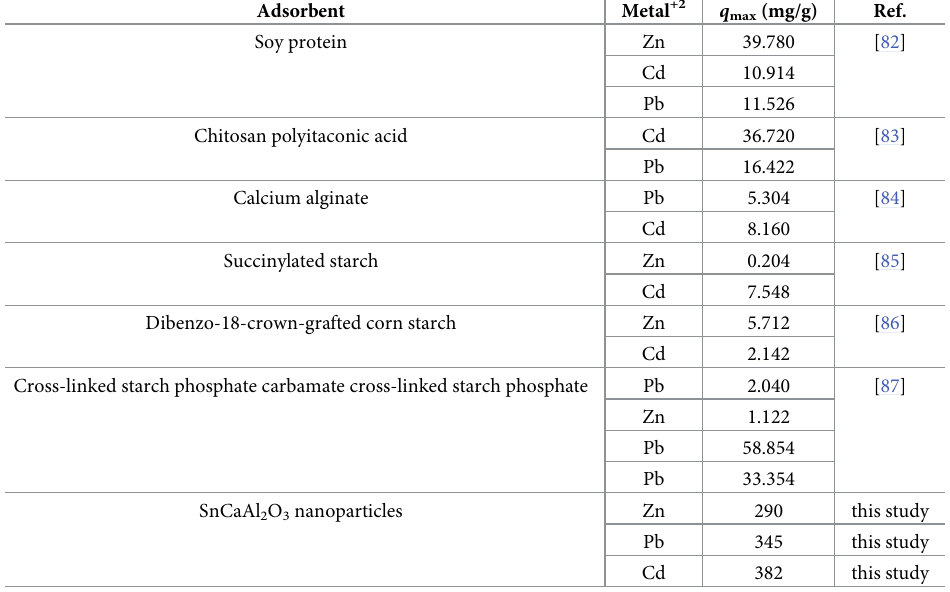
Table 4. The comparison of maximum adsorption capacity of Zn +2 , Pb +2 , and Cd +2 on various adsorbents at neu- tral pH (6.5–8.5). Adsorbent